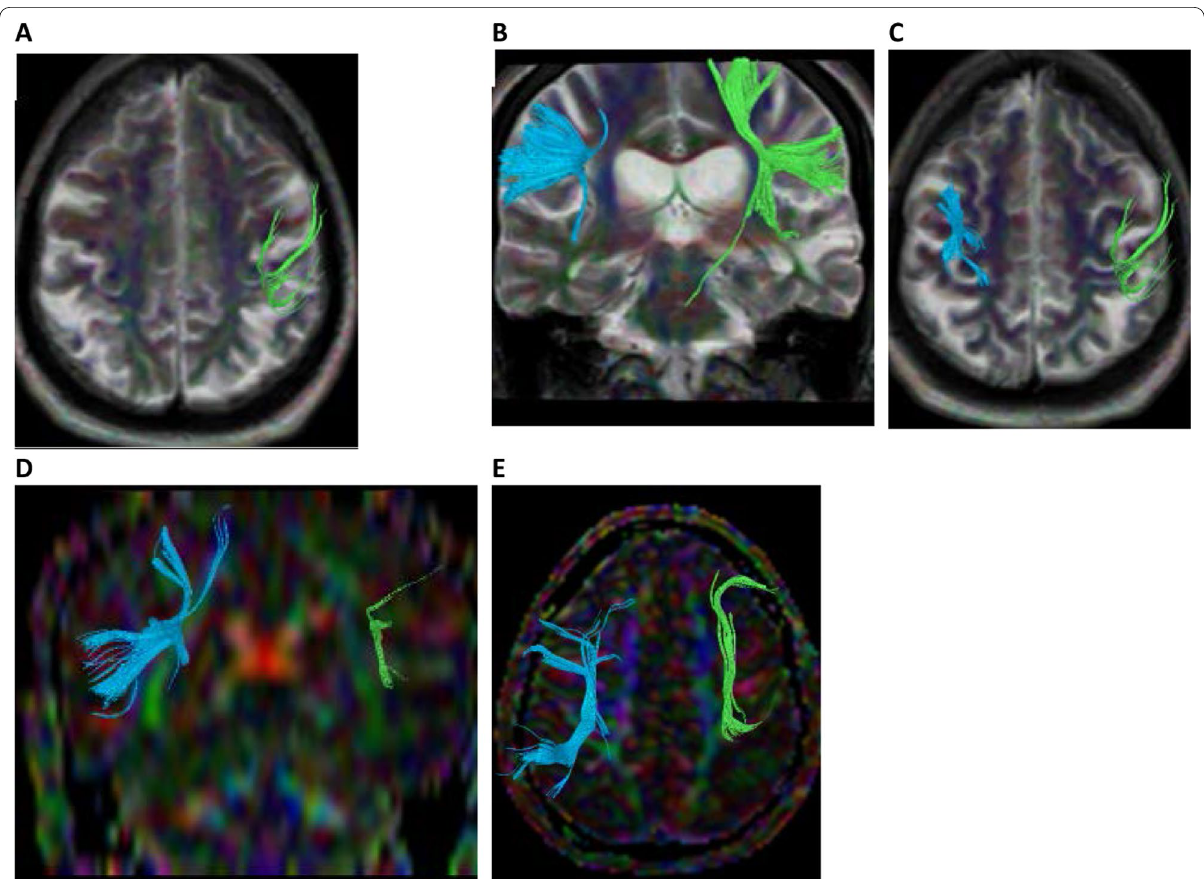
Fig. 5 DTI of patient with sever aphasia: 61‑year‑old patient with a axial T2 reconstructed Lt SLF with marked thinning and atrophy of its fibers, b coronal T2 reconstructed AF shows the Lt AF also with sever atrophy, c axial T2WI for both SLF with marked thinning. d Coronal reconstructed AF and e axial reconstructed SLF in another patient with similar